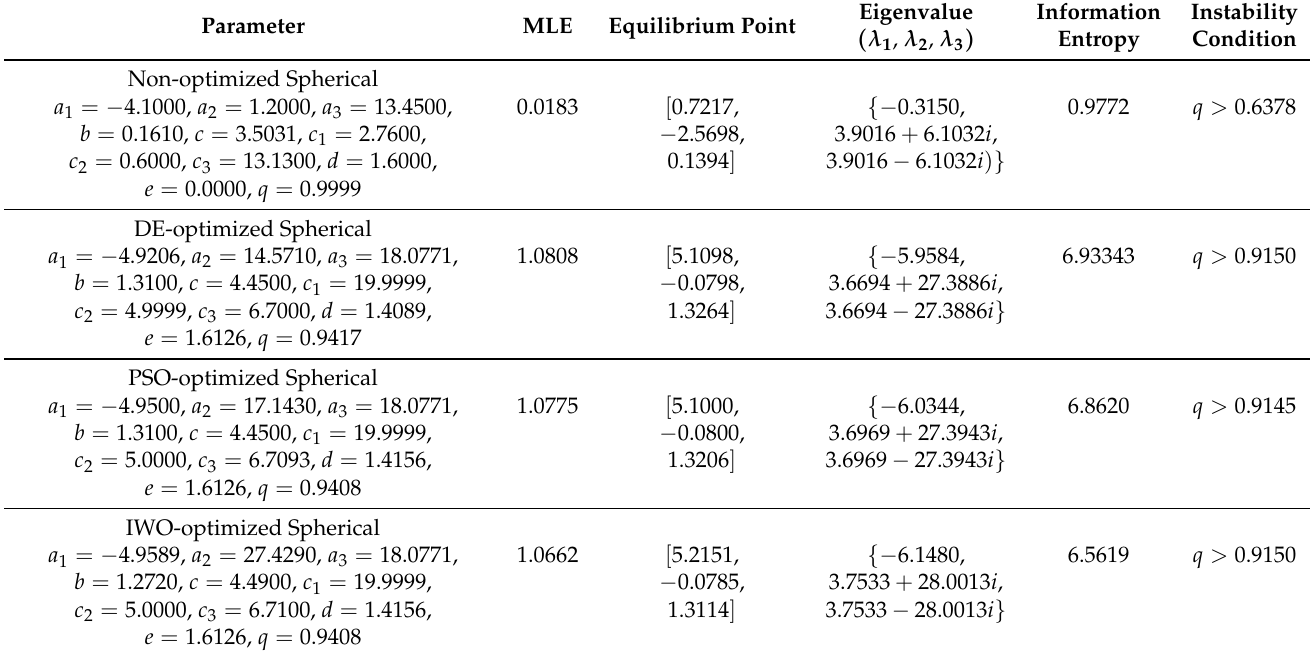
Table 1. Optimization results for fractional-order chaotic system (2), showing the DE, PSO, and IWO-optimized systems against the non-optimized